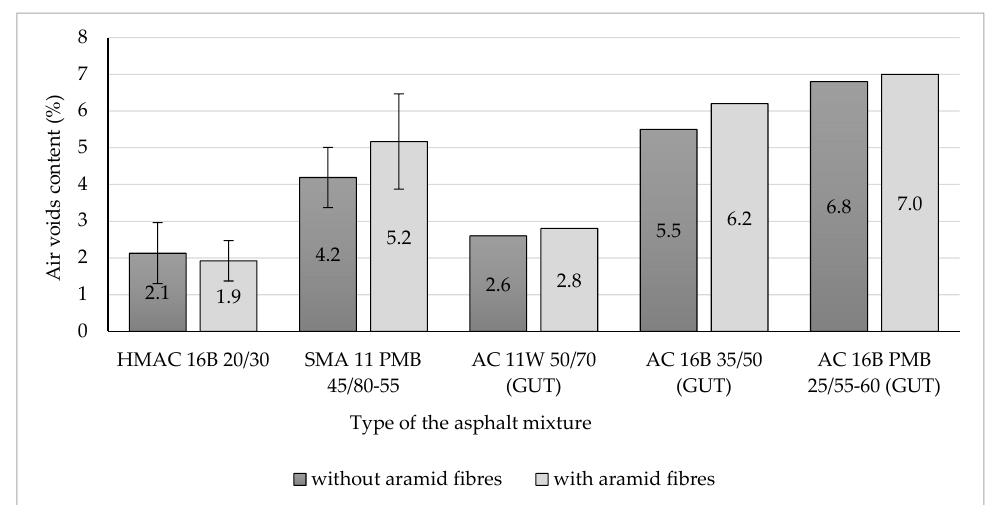
Figure 4. Air voids content of analysed asphalt mixtures (including HMA examined at the Gdańsk University of Technology [26]).